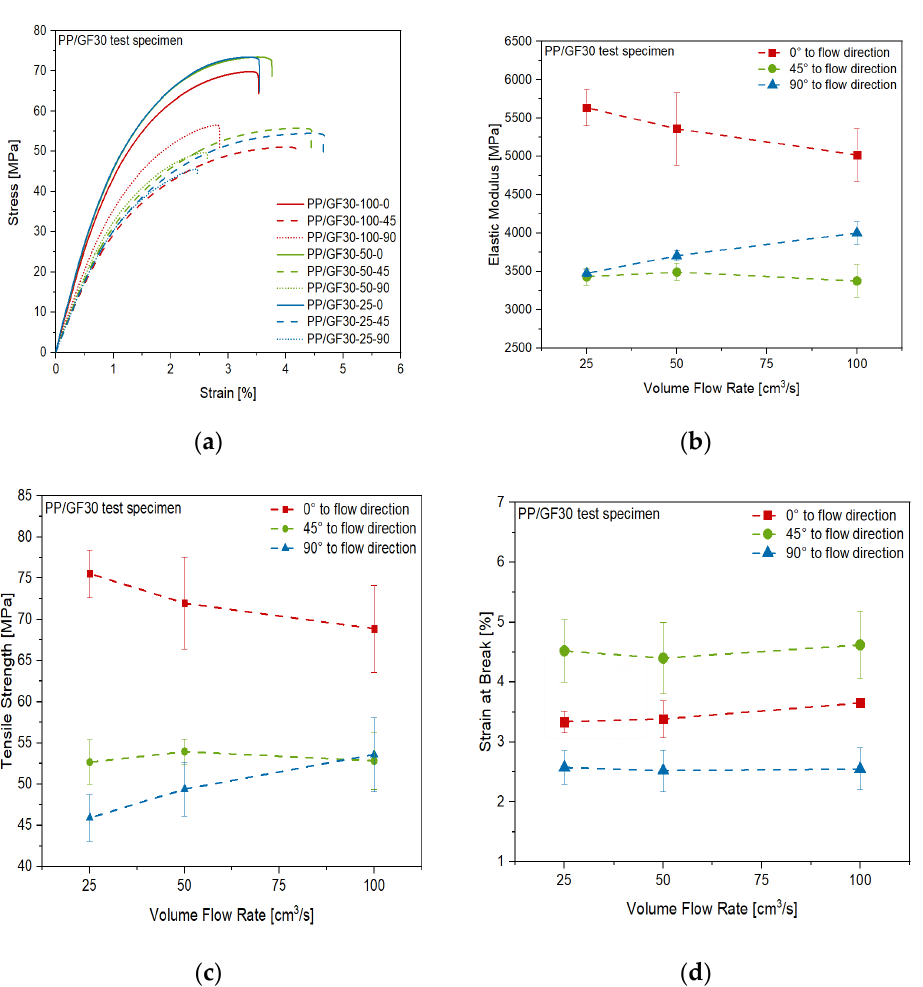
Figure 13. Anisotropic mechanical properties of the PP/GF30 short fiber-reinforced thermoplastic composite as a function of volume flow rate during injection molding: ( a ) stress-strain diagram from tensile test, ( b ) elastic modulus, ( c ) tensile strength and ( d ) strain at break.